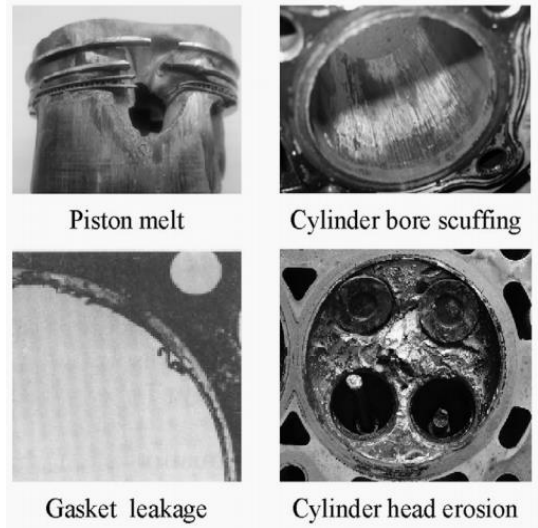
Figure 1. Examples of the knocking